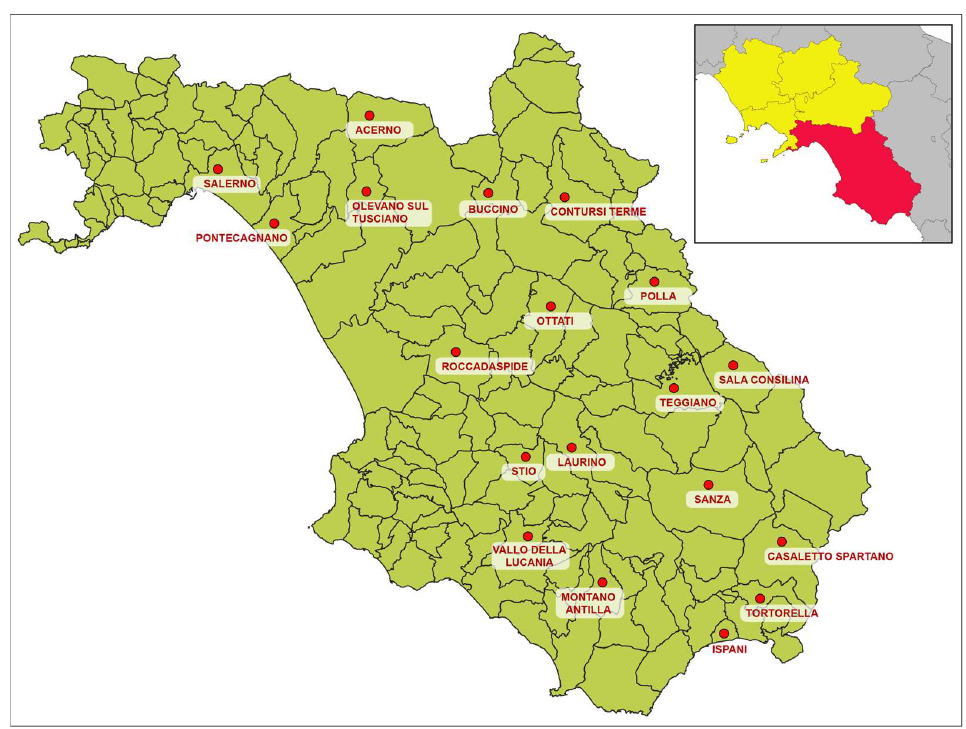
Figure 3. Distribution of firms’ headquarters and stakeholders’ workplaces.